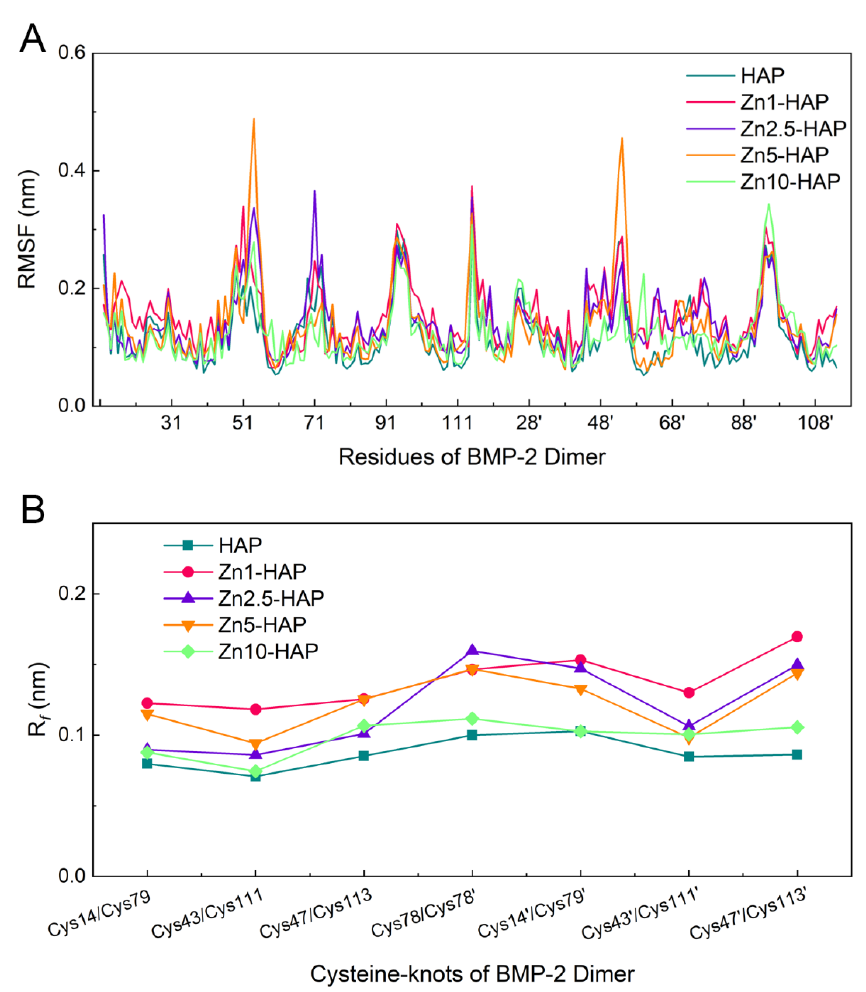
Figure 5. RMSF ( A ) of BMP-2 residues and R f ( B ) of cystine-knots of BMP-2 upon HAP and Zn-HAPs during the adsorption (MD relaxation) process.